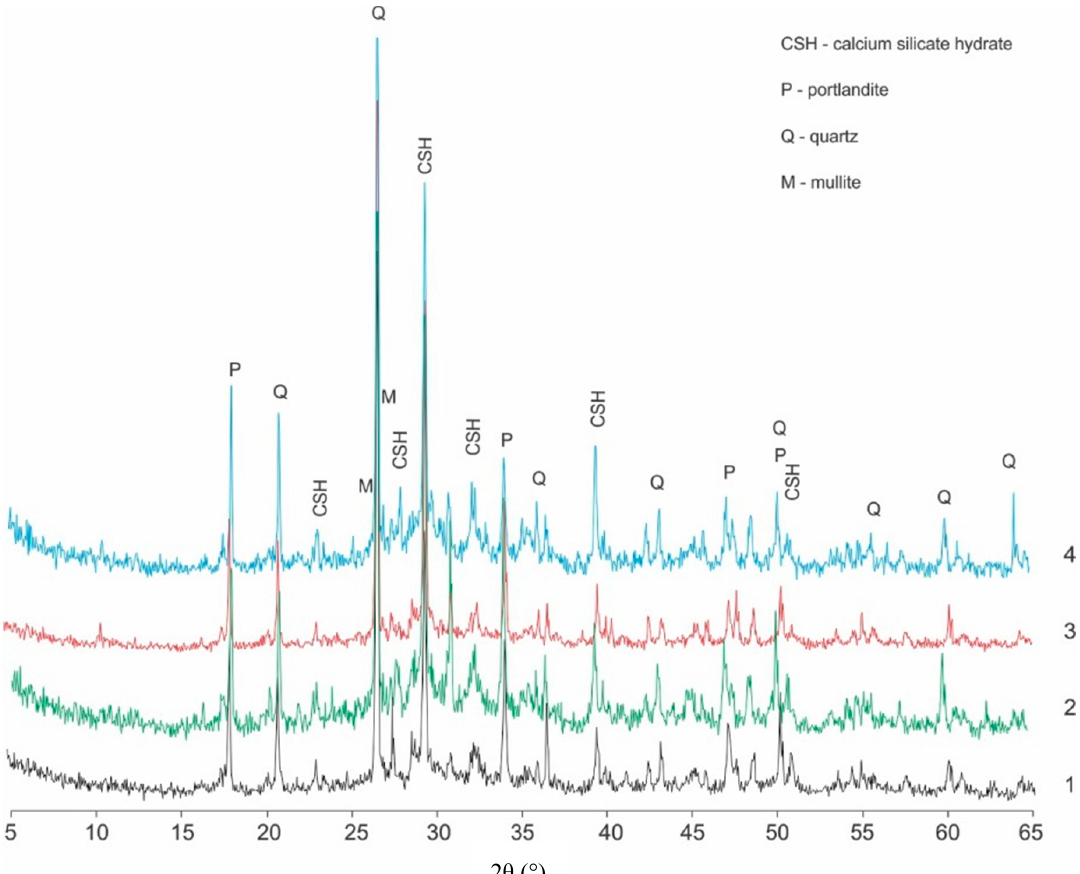
Figure 1. X-ray diffraction pattern of LCD material.